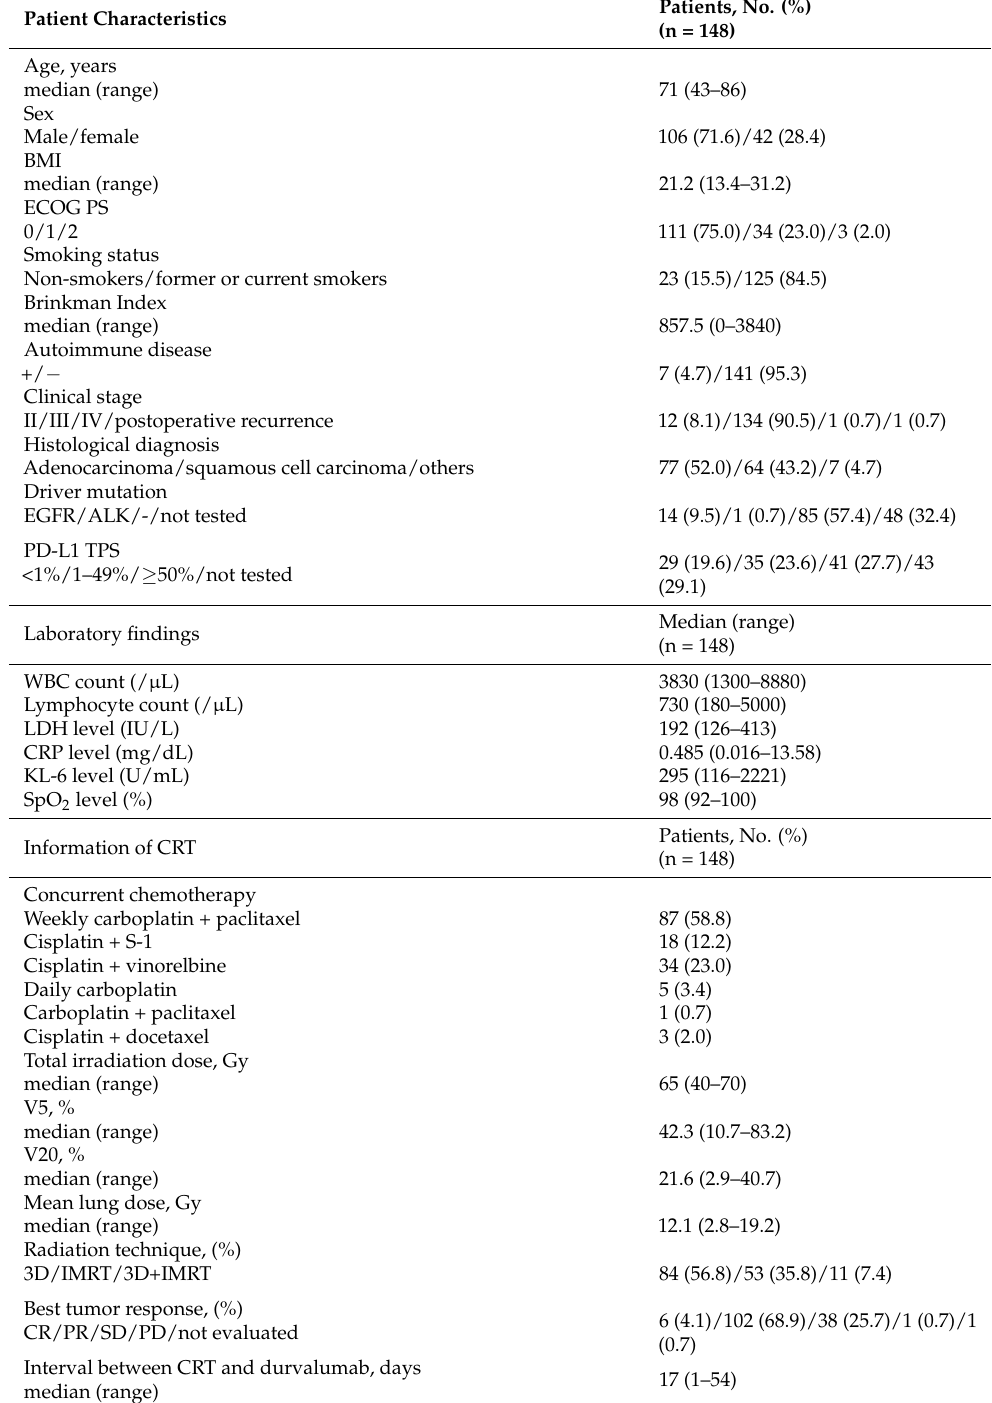
Table 1. Baseline patient characteristics and laboratory